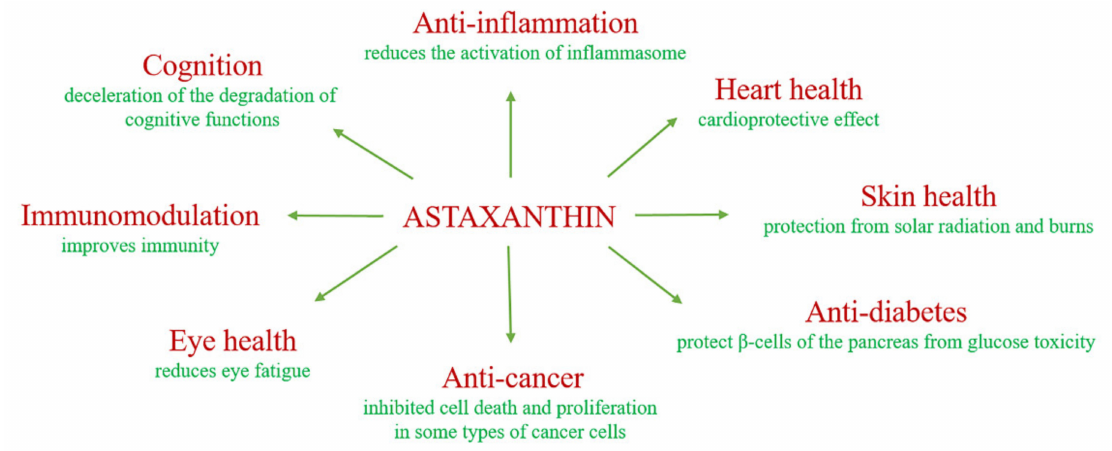
Figure 2. Scheme of the biological benefits of